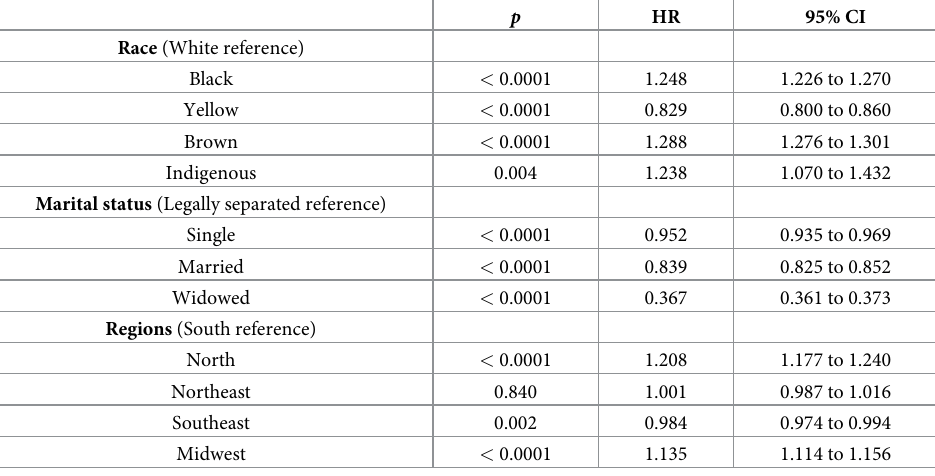
Table 2. Colorectal cancer survival rates according to geographic region, racial classification and marital status in Brazil between 2000 and 2019 using Cox regression univariate analyses, in relation to the largest category of